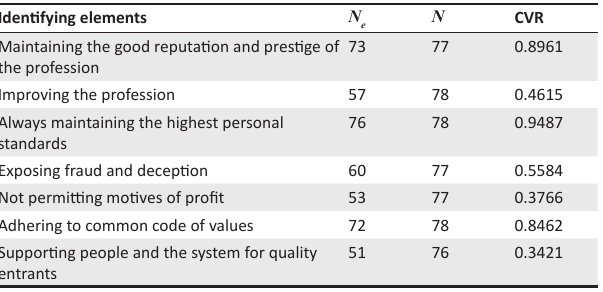
TABLE 8: Content Validity Ratio (Lawshe) of responsibility towards